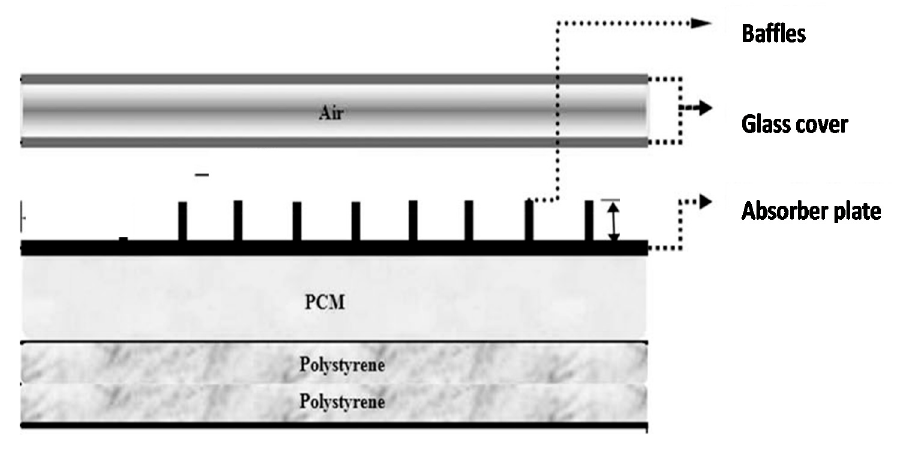
Figure 2. PCM embedded below the collector (Source: Ghiami et al. [13])